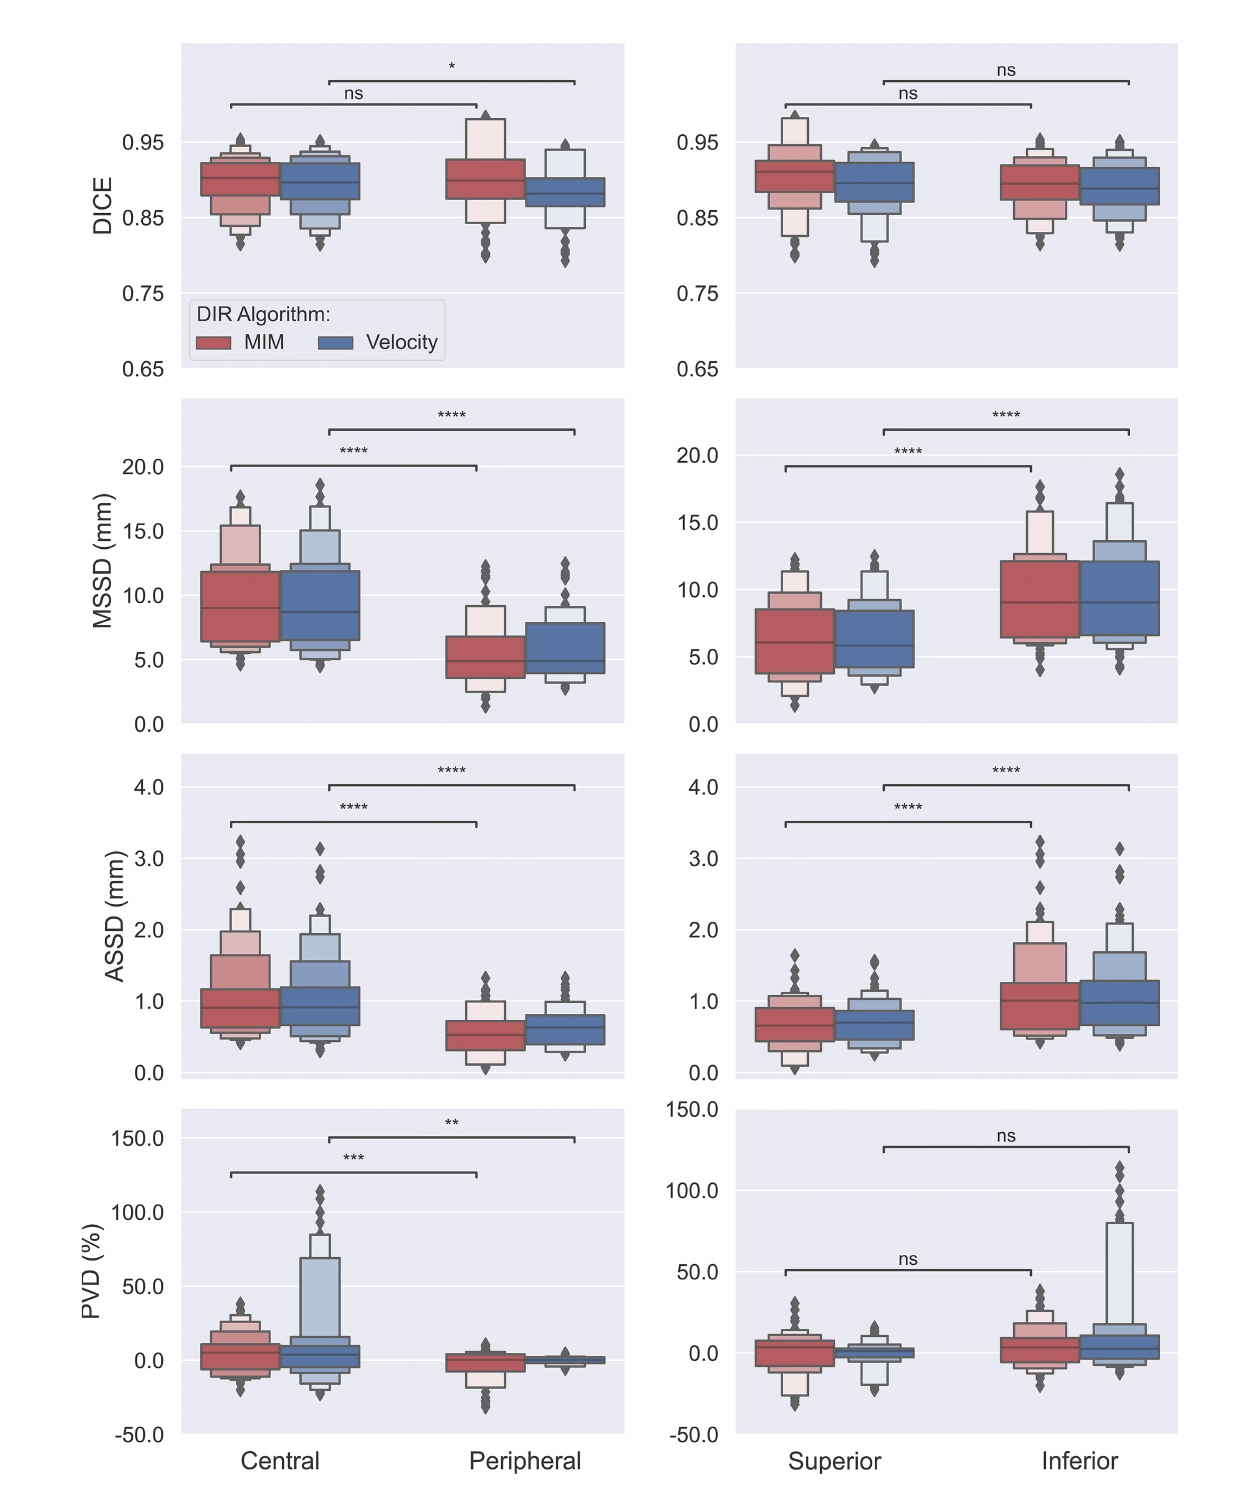
FIGURE 5 | Box plots comparing accuracies of auto-propagated internal gross tumor volumes (AP-IGTVs) from the two employed deformable image registration (DIR) algorithms — MIM (red) and Velocity (blue) — relative to their corresponding ground-truth internal gross tumor volumes (GT-IGTVs) in terms of Dice coef fi cient (DICE), maximum symmetric surface distance (MSSD), average symmetric surface distance (ASSD), and percent volume difference (PVD) along the central – peripheral, and superior – inferior dimensions. On each box, the central mark indicates the median, and the top and bottom edges of the box indicate the 25th and 75th percentiles, respectively. For each box pair comparison, NS: not signi fi cant at level of 0.05; *: p < 0.05; **: p < 0.01; ***: p < 0.001; ****: p < 0.0001.